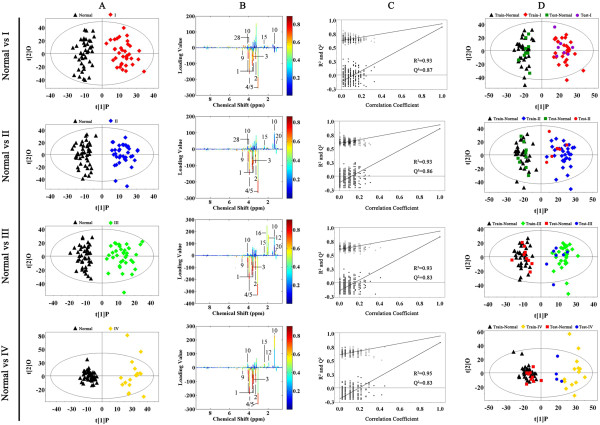
Metabolite profiles between different stages of rectal cancer tissues and normal controls. A OPLS-DA scores plots based on each stages of rectal cancer tissues and normal controls; black triangles represent normal controls (n = 43); red diamonds represent stage I (n = 35); blue diamond’s represent stage II (n = 37); green diamonds represent stage III (n = 37); yellow diamonds represent stage IV (n = 18). B Color map showed the significance of metabolite variations between the classes. Peaks in the positive direction indicated the increased metabolites in rectal cancer tissues. Decreased metabolites in rectal cancer tissues were presented as peaks in the negative direction. C Statistical validation of the corresponding PLS-DA models using permutation analysis (200 times). R2 is the explained variance, and Q2 is the predictive ability of the model. D Scores plots of OPLS-DA prediction model. 80% of samples were applied to construct the model, and then used it to predict the remaining 20% of samples.